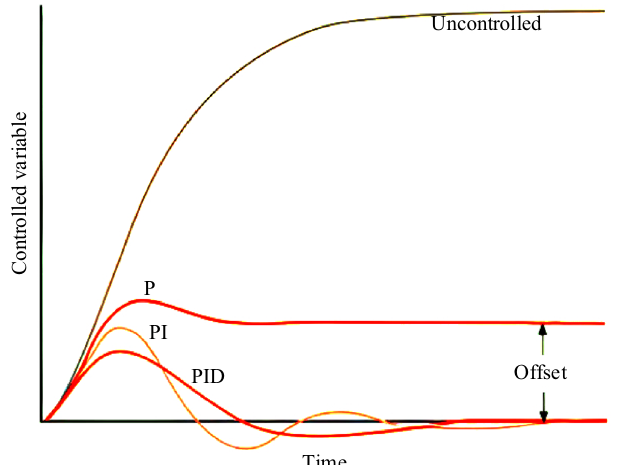
Figure 4. Comparison of three modes P, PI, and PID.